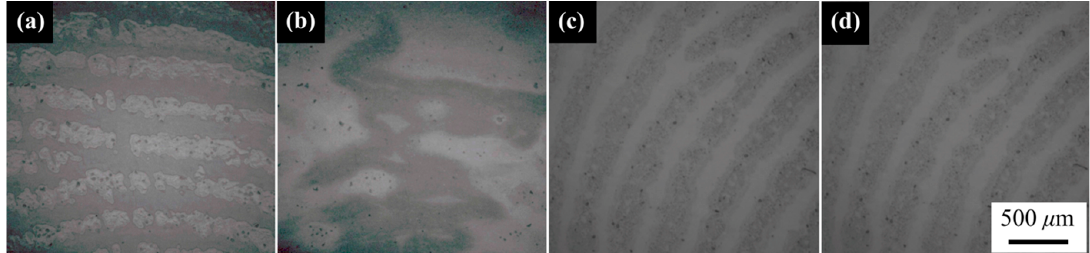
Figure 2. Optical micrograph of fingerprint on ( a , b ) HNL and ( c , d ) untreated glass taken ( a , c ) just after the fingerprint attachment and ( b , d ) 10 min later. The fingerprint only on HNL blurred as shown in ( b ) though that on the untreated glass remained unchanged.